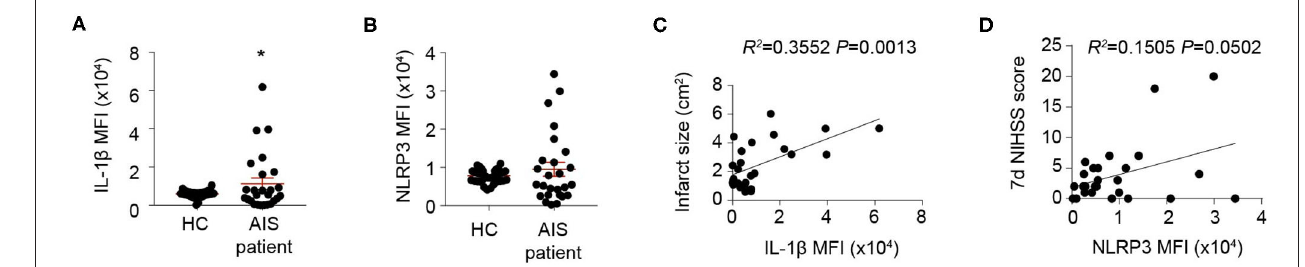
FIGURE 1 | Inflammasomes are activated and indicates detrimental stroke outcome. (A,B ) Peripheral blood samples were collected from 40 healthy controls (HC) and 26 patients suffering an acute ischemic stroke (AIS) within the first 24h of symptom onset. Inflammasome markers IL-1 β (A) and NLRP3 (B) were analyzed with flow cytometry. * P < 0.05 vs. HC in Student t-test . (C,D) Mean fluorescent intensity (MFI) of IL-1 β was calculated and correlation of IL-1 β MFI with infarct size was analyzed with Linear regression (C) , and MFI of NLRP3 was calculated and correlation of NLRP3 MFI with NIHSS score at 7 d after disease onset (D) was analyzed with Linear regression .